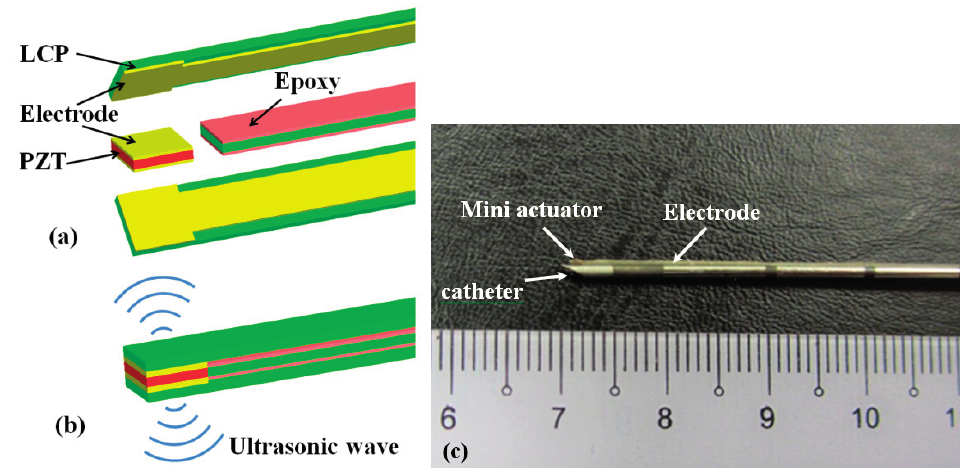
Figure 2. Sketches of: ( a ) the lead zirconate titanate (PZT) element being bonded between two flexible electrodes patterned on LCPs and ( b ) the assembled device; and ( c ) a photo of the ultrasound mini actuator attached to an 18 G biopsy